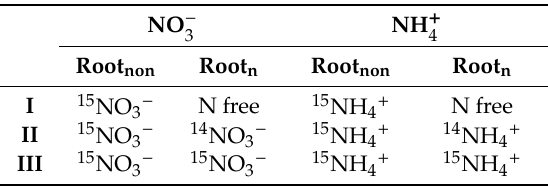
Table 1. Experimental